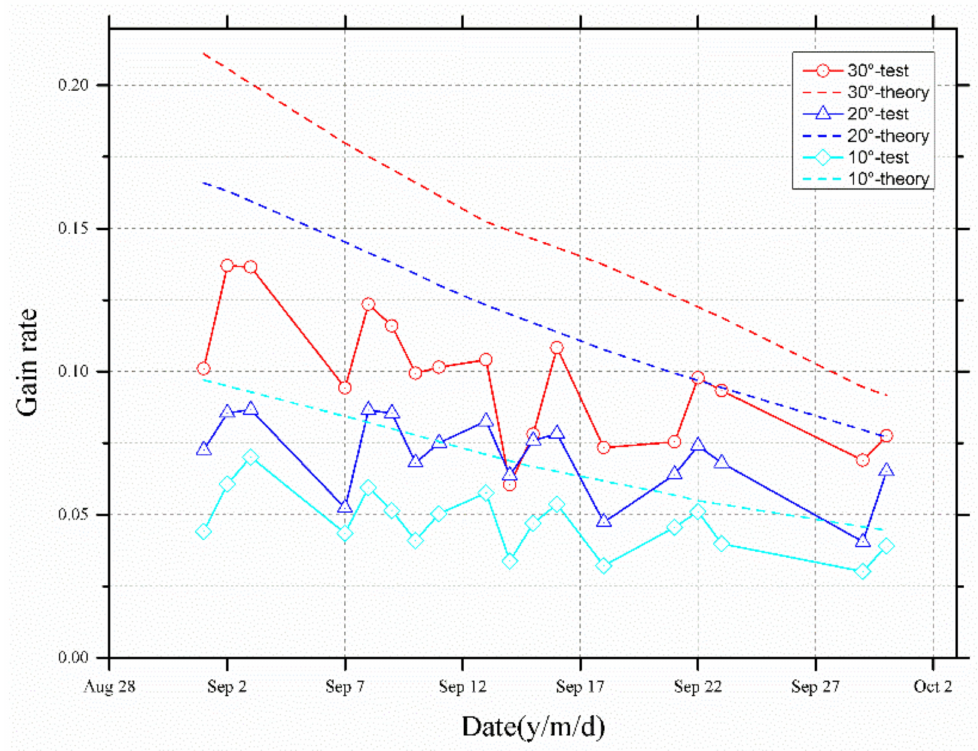
Figure 16. Test value vs. theoretical value of the daily gain ratio before and after light supplementation for the prototype system in